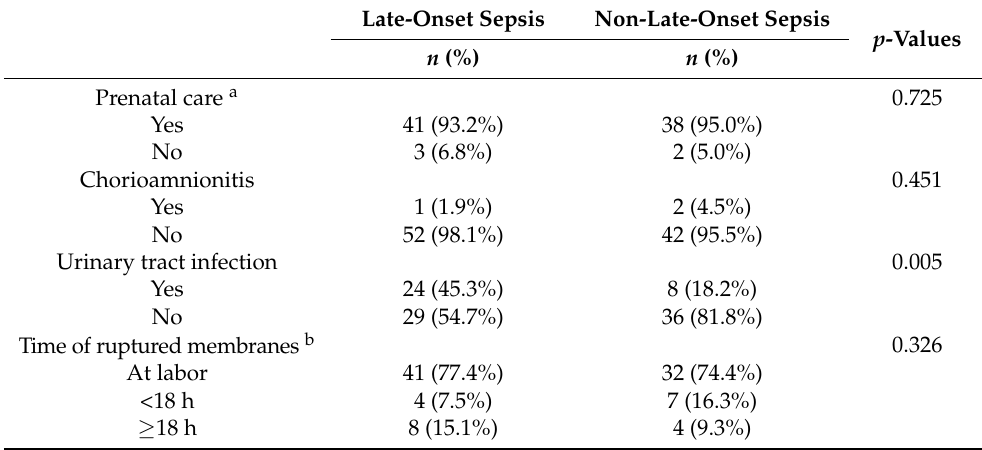
Table 3. Association between maternal variables and infants with late-onset sepsis ( n = 97).